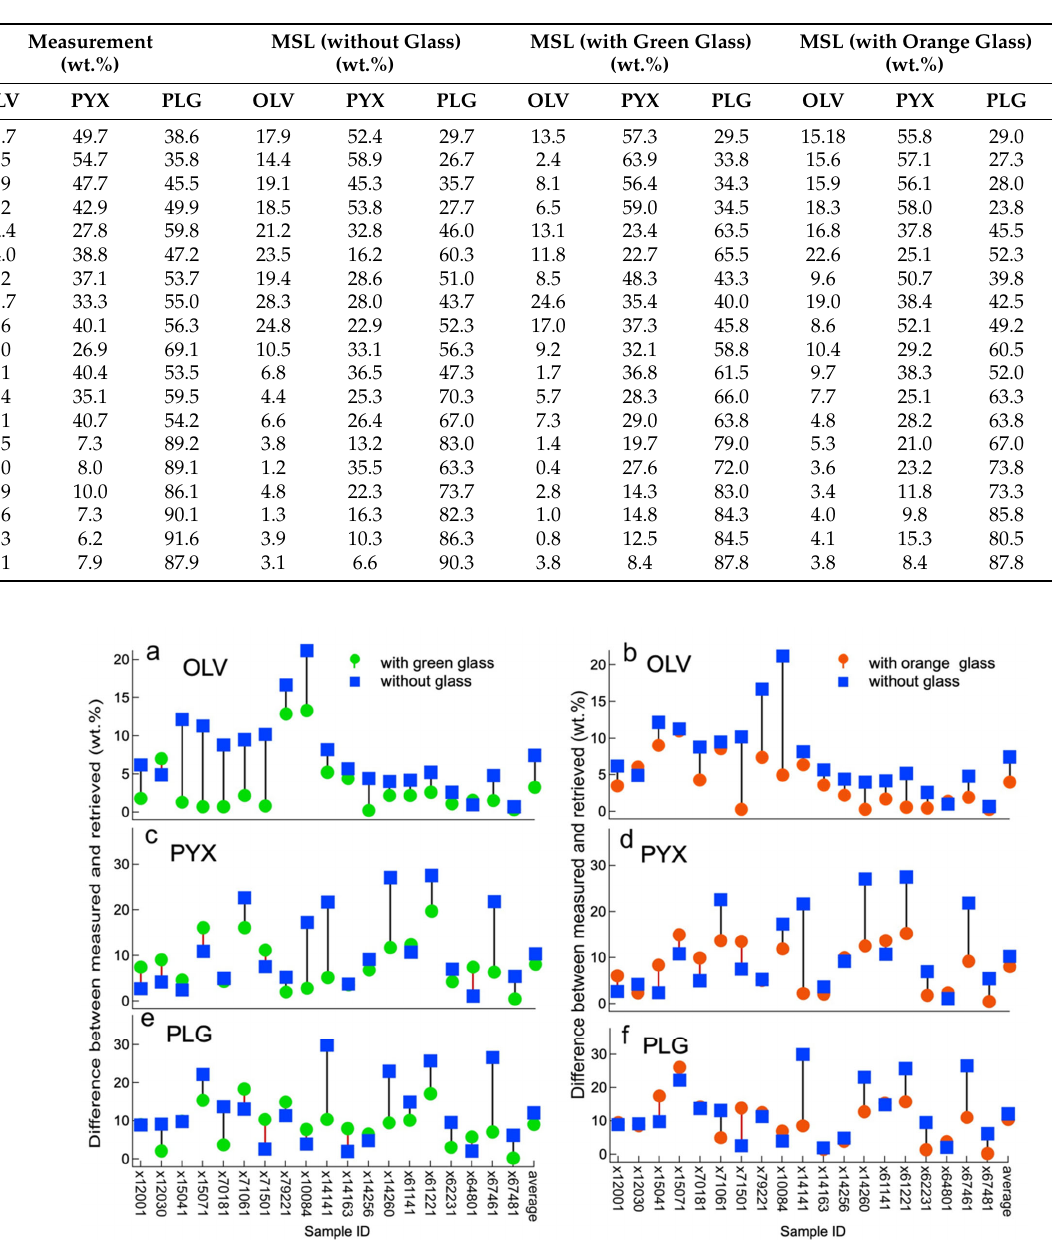
and the LSCC measurement value. The circles and squares indicate the difference between the LSCC measurement and the MSL retrieval results with and without taking into account glass. The fact that most circles are below the squares indicates that adding glass as the endmember improves retrieval accuracy. Table 2. Relative abundance (wt.%) of the three minerals (OLV + PYX + PLG = 100 wt.%) retrieved Table 2. Relative abundance (wt.%) of the three minerals (OLV + PYX + PLG = 100 wt.%) retrieved from the MSL with and without considering glass and the LSCC measurement results. from the MSL with and without considering glass and the LSCC measurement results.